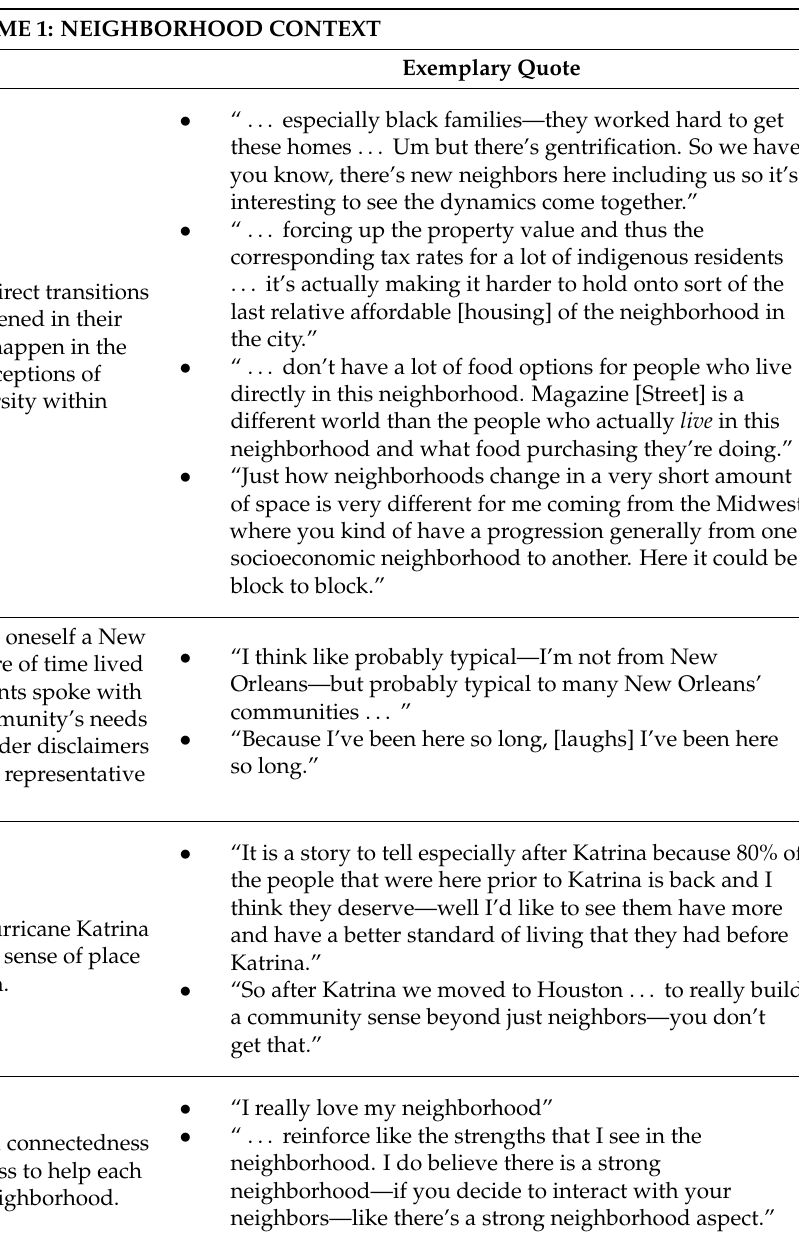
Table 3. Themes Identified in the Post-Journey